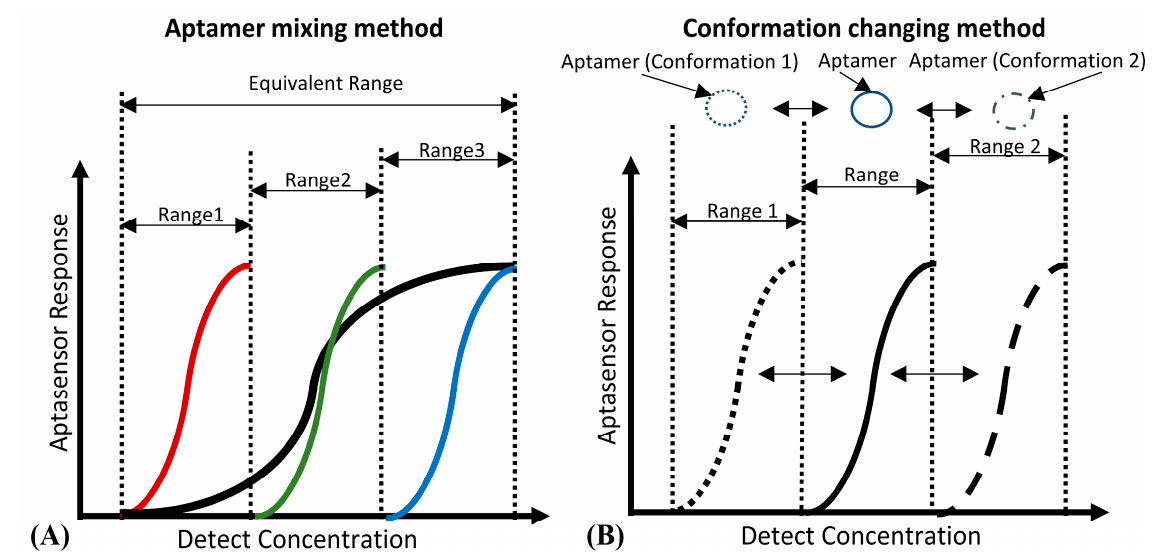
Figure 3. ( A ) The principle of the “aptamer mixing method”. It can be seen that the detection ranges of aptamers, which have a high affinity (marked in red), medium affinity (marked in green) and low affinity (marked in blue) to the same biotarget, are narrow. However, the equivalent detection range of their mixture is wide. ( B ) The principle of the “conformation changing method”. By inducing the aptamer to change to the conformation with high affinity (Conformation 1), and the conformation with low affinity (Conformation 2), the detection range of the aptamer can shift to the low detection concentration area (Range 1) and the high detection concentration area (Range 2) respectively.